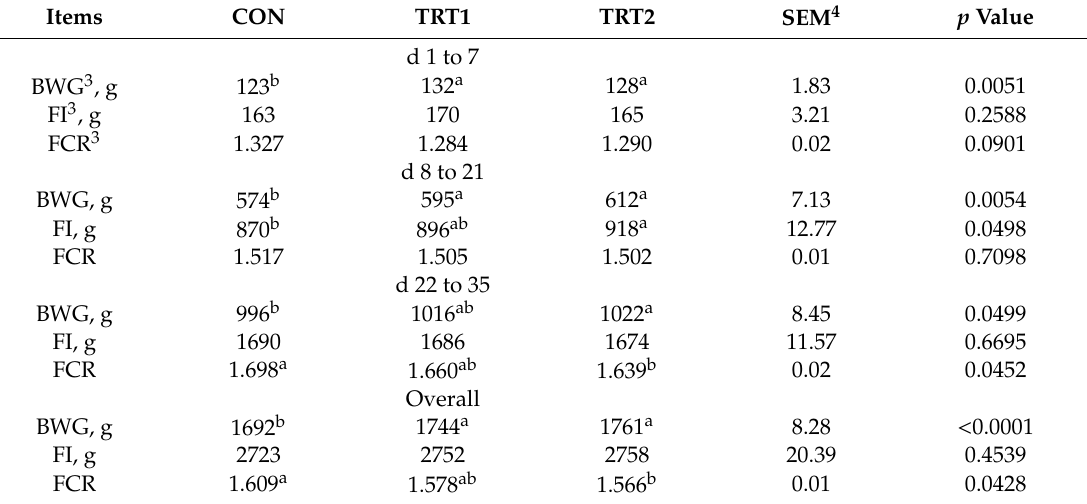
Table 3. The e ff ect of dietary DOL supplementation on growth performance in broilers † ,